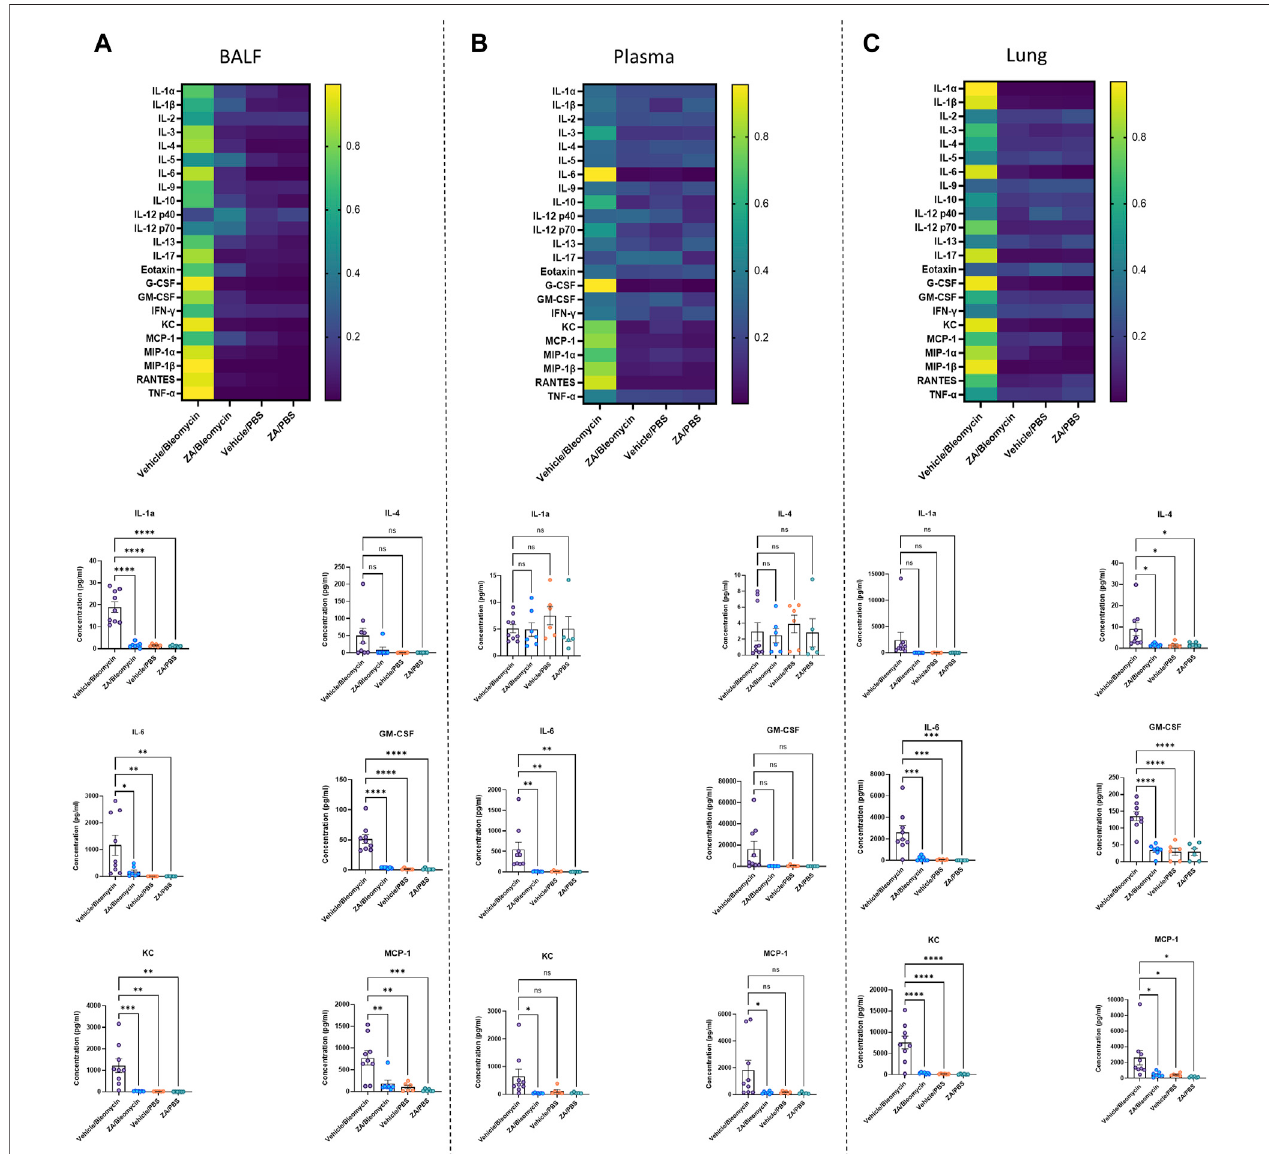
FIGURE 5 | Signi fi cantly decreased murine cytokines following intraperitoneal ZA administration. Heatmaps (A – C) showing the differences in cytokine levels, as measured by multiplex assay, in murine BALF, plasma, and lung homogenate (yellow indicating high value; blue indicating low value) with selected corresponding signi fi cantly decreased or increased cytokine levels below. Cytokine values were compared to the vehicle/bleomycin group using a one-way ANOVA followed by a Dunnett ’ s post-hoc test (* p < 0.05 ; **p < 0.01 ; ***p < 0.005 ; ****p < 0.001).